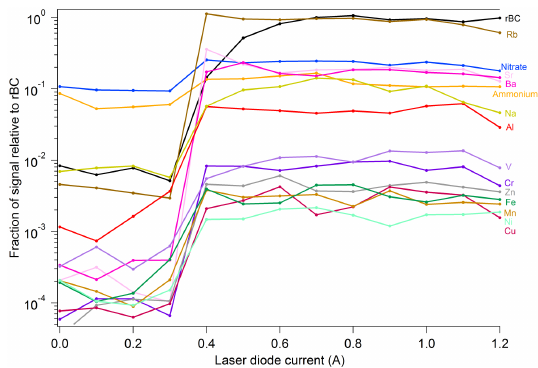
Figure 3. Fraction of metals signal (Hz) relative to the highest rBC signal (Hz) as a function of the laser diode current